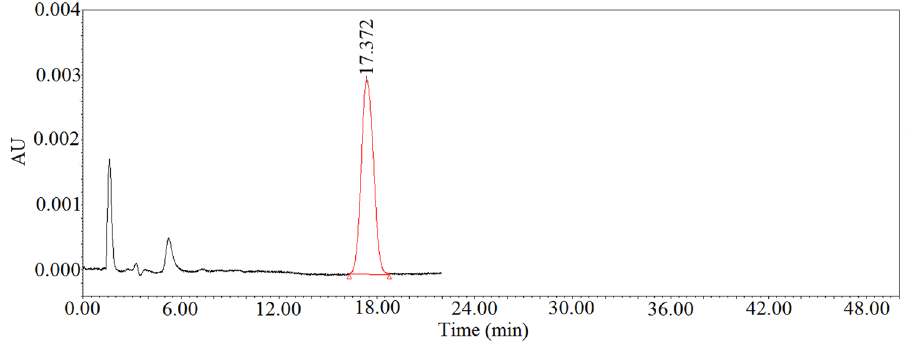
Figure 2: High - performance liquid chromatogram for the 3,3,5,7,7 - pentamethy - l - 1,2,4 - trioxepane standard.